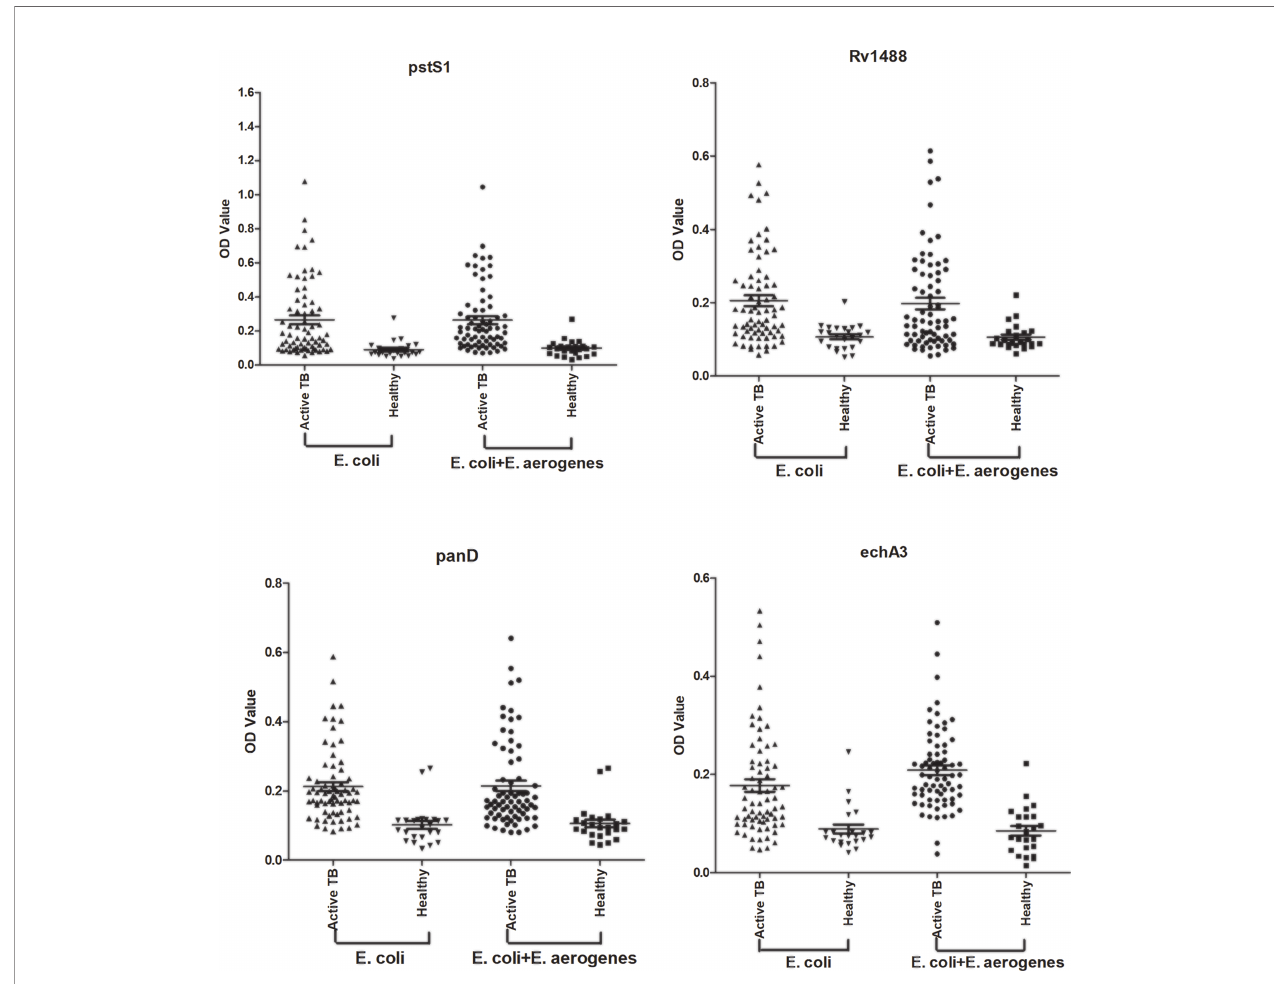
FIGURE 1 | Comparison of the effect of pre-adsorption by E. coli and E. aerogenes and E. coli . A panel of 96 serum samples, including 72 TB patients and 24 healthy controls were recruited. PstS1, Rv1488, PanD and EchA3 four antigens were used to validate it.